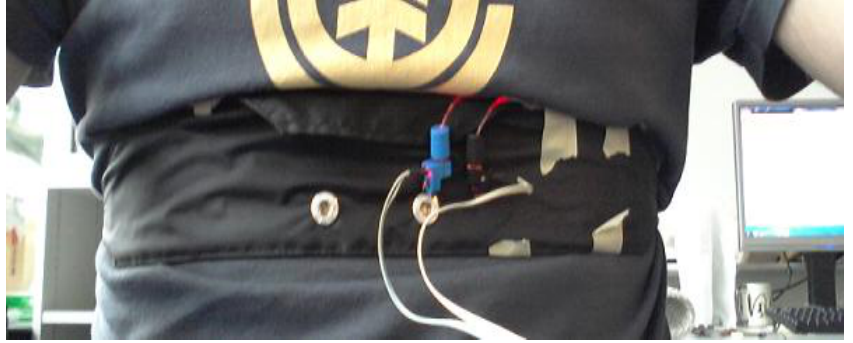
Figure 2. Sensing system placed on a human subject study. Blue and black connectors are housings for the LED and the photodiode, respectively. The power supply is provided by the grey wires.